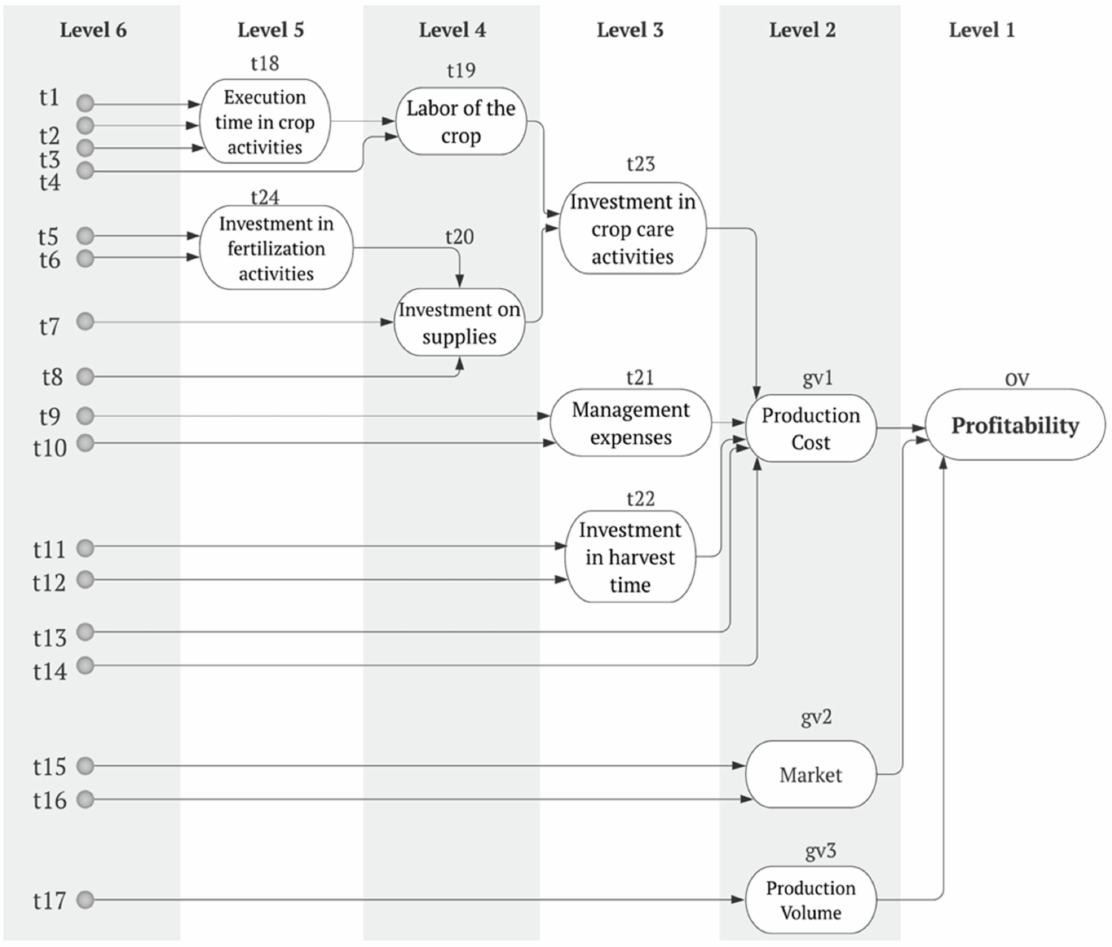
Figure 6. HMP-Coffee conceptual model. Level 1 contains the output variable profitability (vo). Level 2 the global variable production cost (gv1), production volume (gv2) and market (gv3); level 3,4,5 contain 10 aggregate attributes: management expenses (t21), investment in harvest time (t22), investment in crop care activities (t23), labor of the crop (t19), investment on supplies (t20), execution time in crop activities (t18), investment in fertilization activities (24); level 6 includes 17 basic attributes: time spent on fertilization (t1), time spent on renovation (t2), time spent on weed/pest and diseases control (t3), price of the workforce (t4), investment in chemical fertilizers (t5), investment in organic fertilizers (t6), investment in weeds supplies(t7), investment in renovation supplies (t8), investment in maintenance (t9), transportation expenses (t10), payment for coffee harvesting(t11), implements for coffee pickers (12), investment in benefice coffee process (t13), investment in thresh coffee process (t14), variation in the USD price (t15) and New York stock coffee price (t16), and coffee production volume